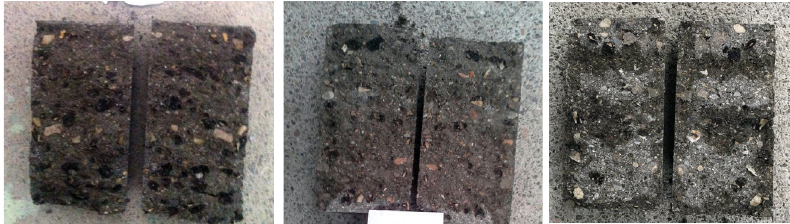
Figure 9. Fracture section of tensile specimens for mixtures R100 (left), R75 (middle), and R50